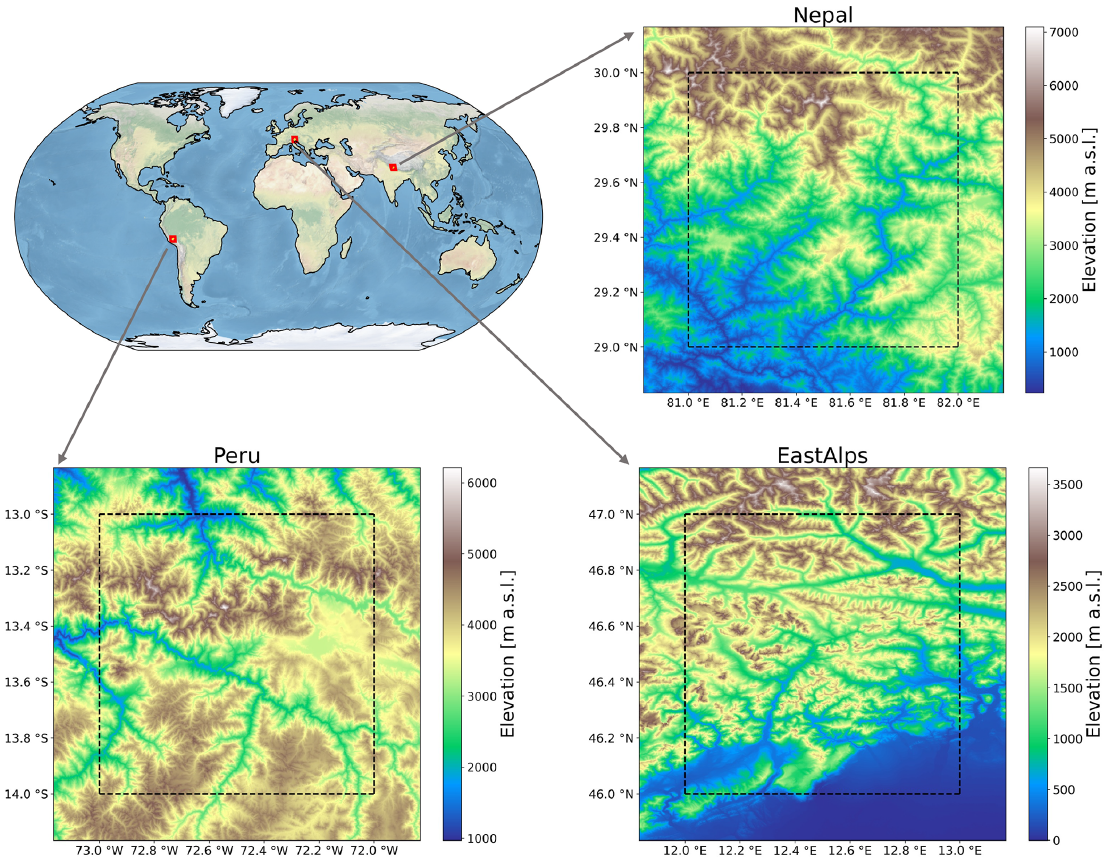
Figure 2. Location of the three land domains selected for this study. For each location, the 90m resolution digital elevation used in the study is